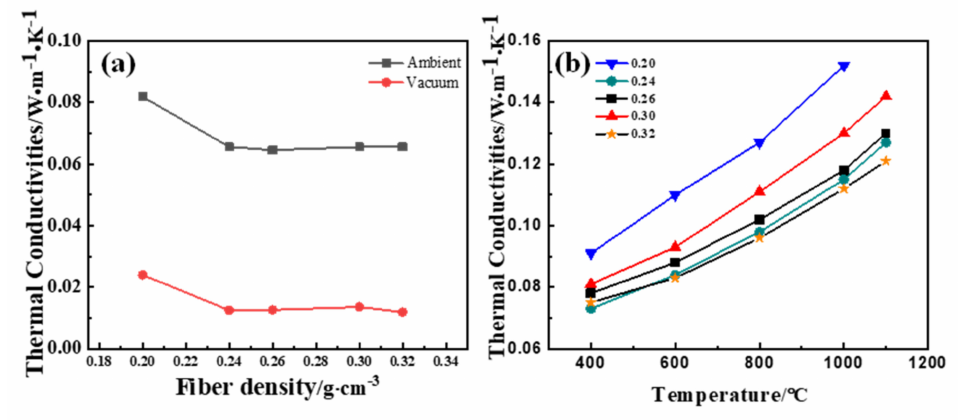
Figure 3. The thermal conductivity of SAC at ( a ) room temperature and ( b ) high temperatures.